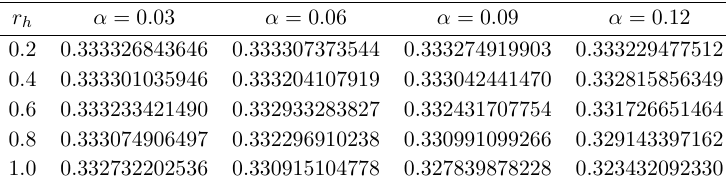
Table 1 . The first ( ‘ = 0 ) angular eigenvalue λ of the accelerating Schwarzschild AdS black holes with Λ = − 3 .